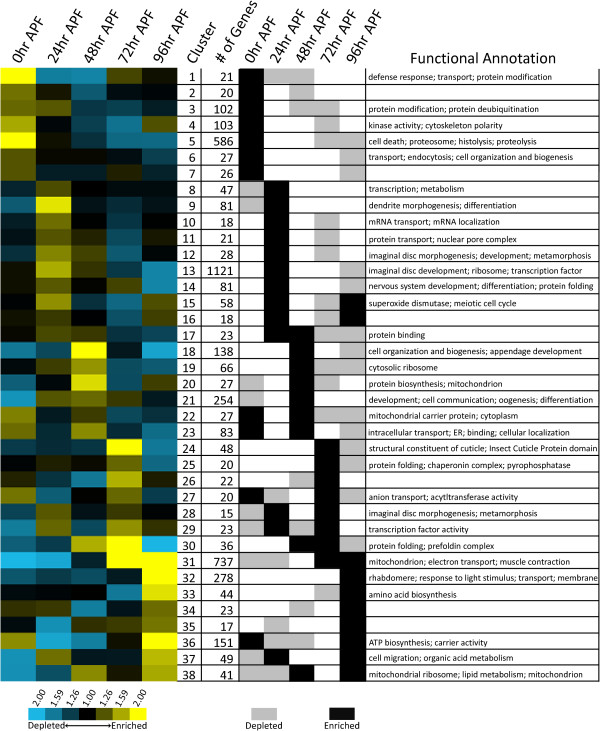
Clusters of genes with similar expression profiles in somatic tissues during metamorphosis. Clusters were generated using gene expression data from male and female tud progeny at five time points during metamorphosis, indicated at top of clustergram. Expression profiles for each cluster were generated by averaging the gene expression data at each time point for every gene in the cluster in both sexes. Yellow and blue indicates high and low levels of expression compared to a common reference, respectively. To the right of the clustergram, black and grey indicates a cluster in which gene expression is at a peak (enriched) or at a trough (depleted), respectively, relative to the average expression value across all time points. Clusters are at a peak or trough of expression if average expression was 2/3 of a standard deviation above or below the mean expression value of the five time points, respectively. Functional annotation represents functional categories that were overrepresented among the genes in the cluster, as determined by the program DAVID (P < 0.05 [22]).